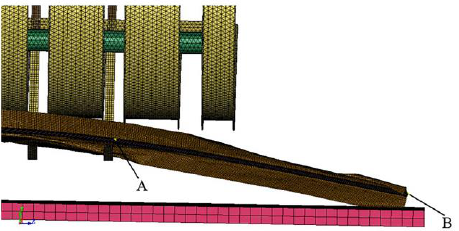
Figure 12. Extraction point of sugarcane leaf bending angle.